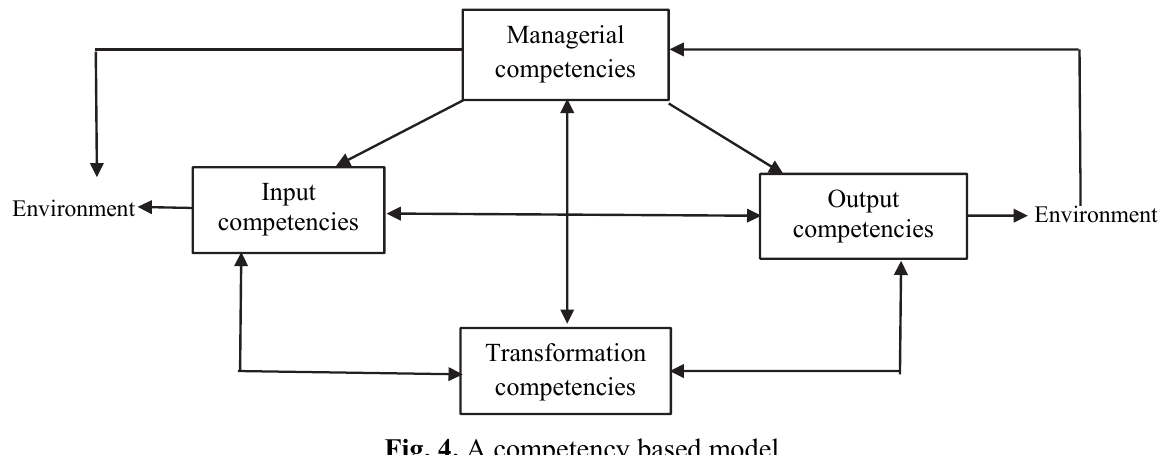
Fig. 4. A competency based model Source: Lado et al.,